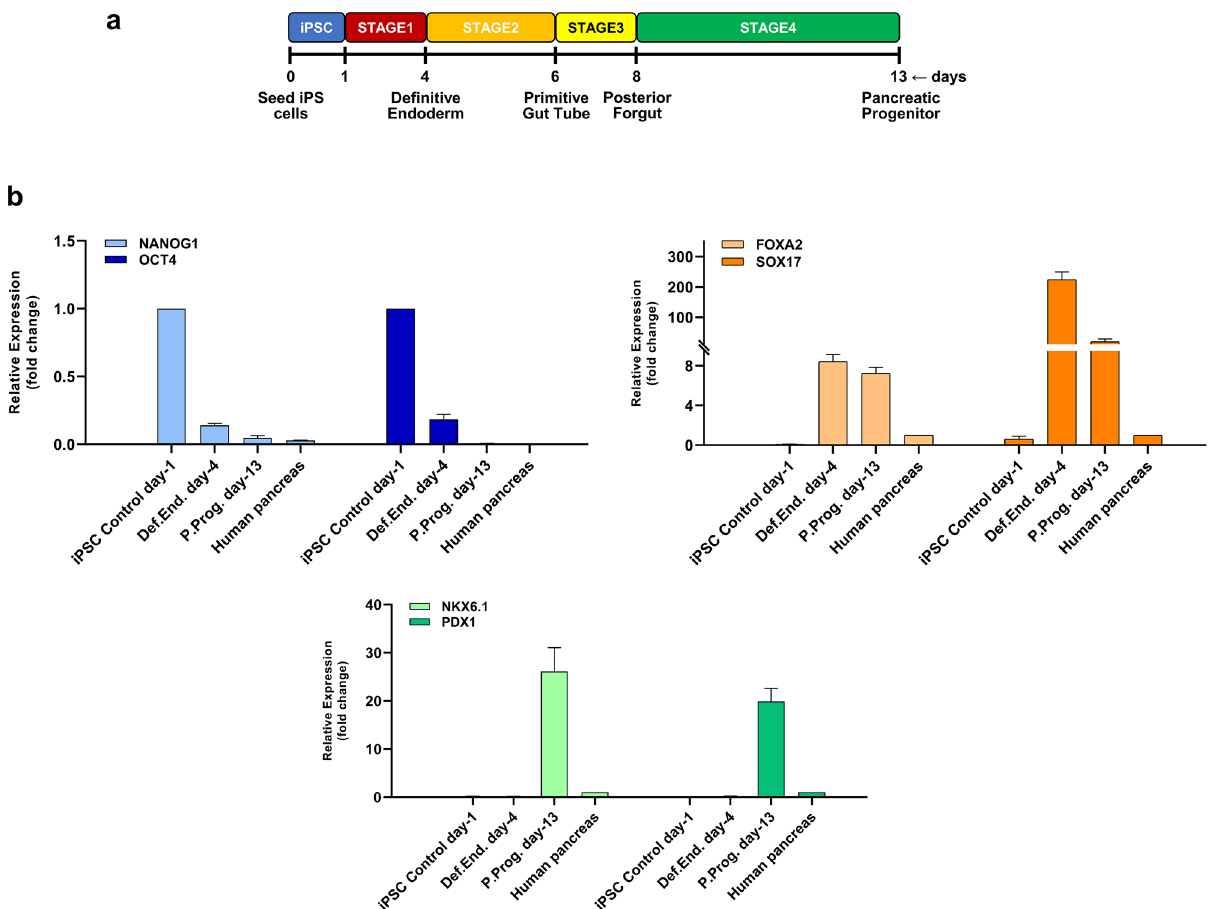
Figure 6. Pancreatic differentiation of SBAD2-iRFP720 reporter hiPSCs in 3D culture system. ( a ) Schematic for the generation of pancreatic progenitor cells. ( b ) mRNA expression of pluripotency markers (OCT4 and NANOG), definitive endoderm (FOXA2, SOX17) and pancreatic progenitor (NKX6.1, PDX1) markers at the indicated differentiation stages determined by RT-qPCR measurements. Data are presented as mean ± SEM, n =